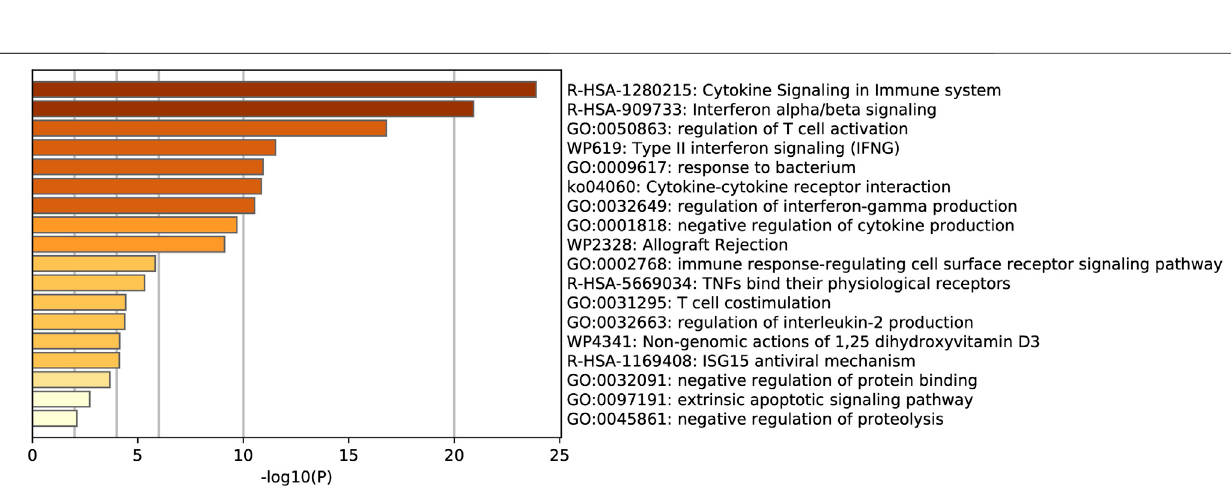
Frontiers in Genetics |